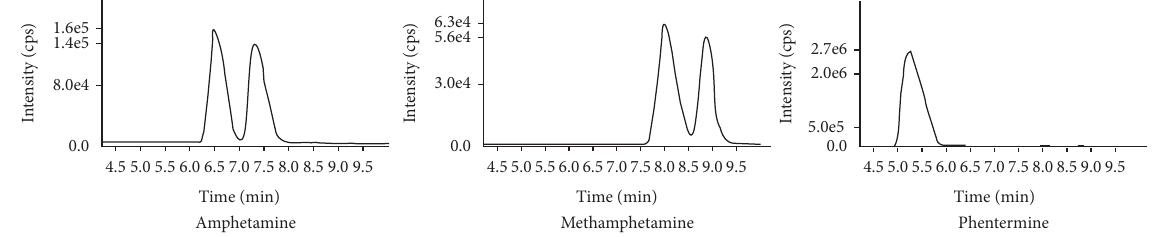
Figure 1: MRM chromatograms of amphetamine, methamphetamine, and